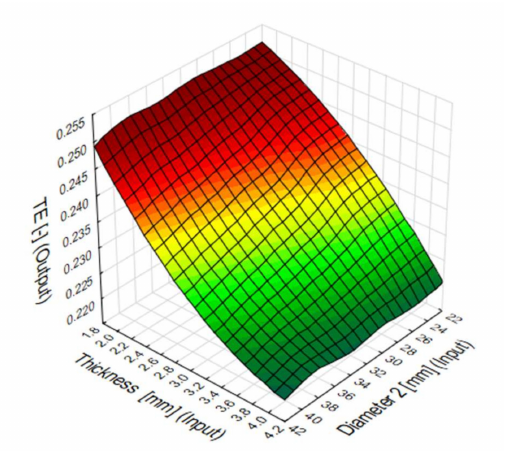
Figure 21. Total e ffi ciency (TE) predicted by MLP 2-7-1 artificial neural network.